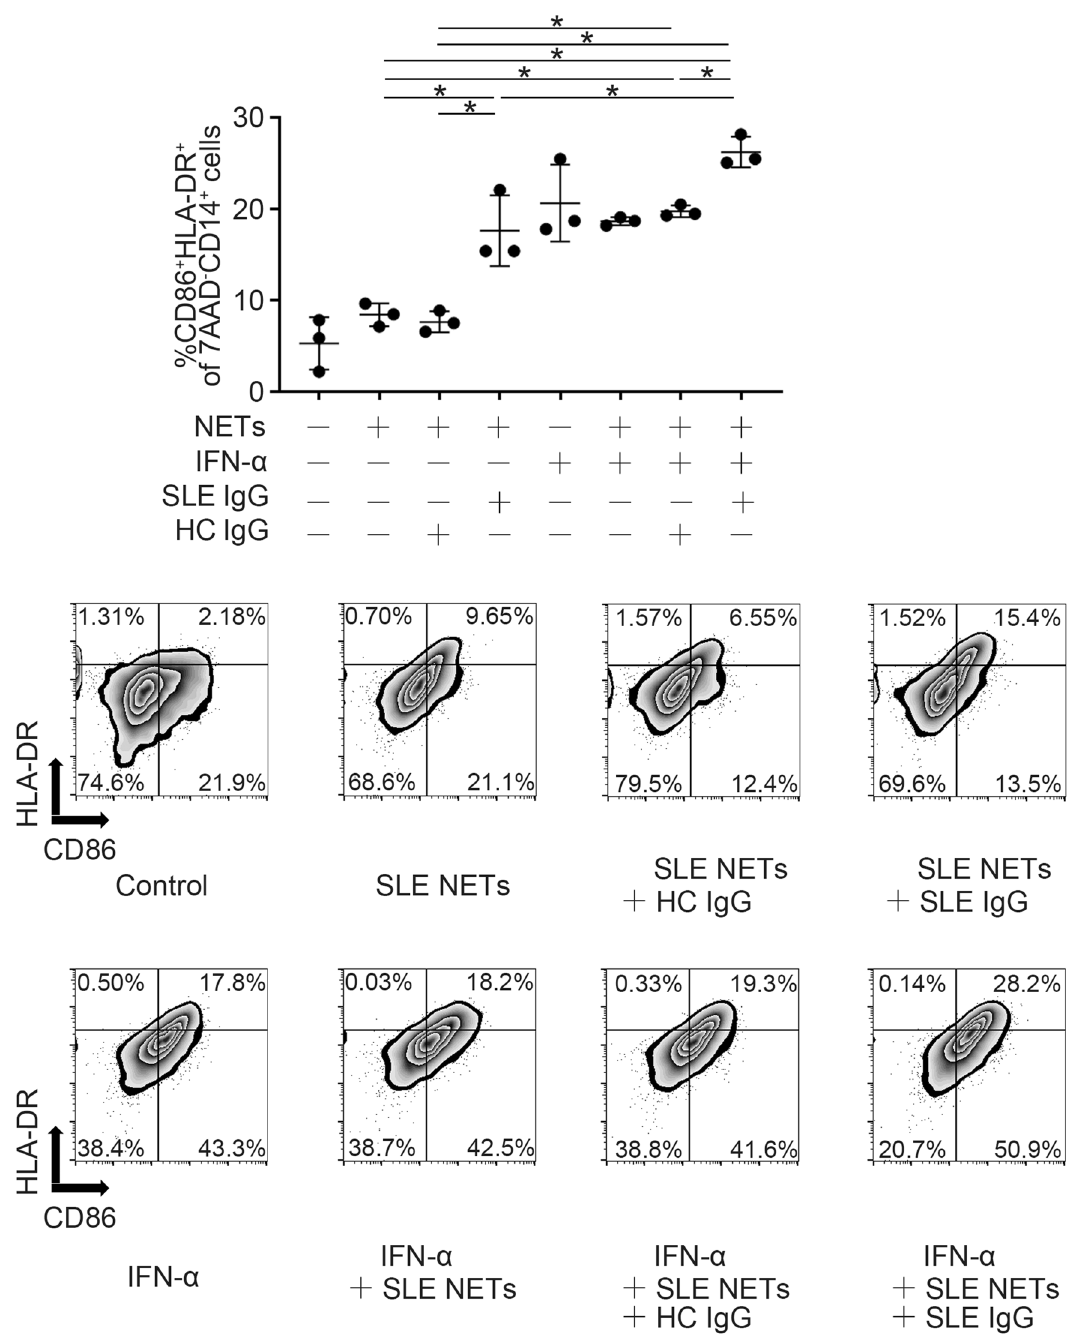
Figure 5. Monocyte stimulation with immune complexes. (Top) Monocytes were seeded at 1 × 10 6 cells/mL and stimulated with 300 ng/mL of SLE patient–derived NETs or with an immune complex (SLE NETs-SLE IgG [10 µg/mL] or SLE NETs-HC IgG [10 µg/mL]), with or without IFN-α, for 2 days. Monocyte activation was evaluated by the proportion of activated monocytes (7AAD - CD14 + CD86 + HLA-DR + ) using a flow cytometer. n = 3 for each stimulation condition. (Bottom) Representative figures of flow cytometric analysis from the conditions on the top. * P < 0.05; one-way ANOVA with Tukey’s multiple comparisons test. Error bars represent mean ± SD (Control, NETs, NETs + HC/SLE IgG, and IFN-α + NETs + HC/SLE IgG were used for multiple comparisons, and error bars were not shown for the result of the comparison between control and each condition.). HC: healthy control; IFN-α: interferon alpha; IgG: immunoglobulin G; NETs: neutrophil extracellular traps; SLE: systemic lupus